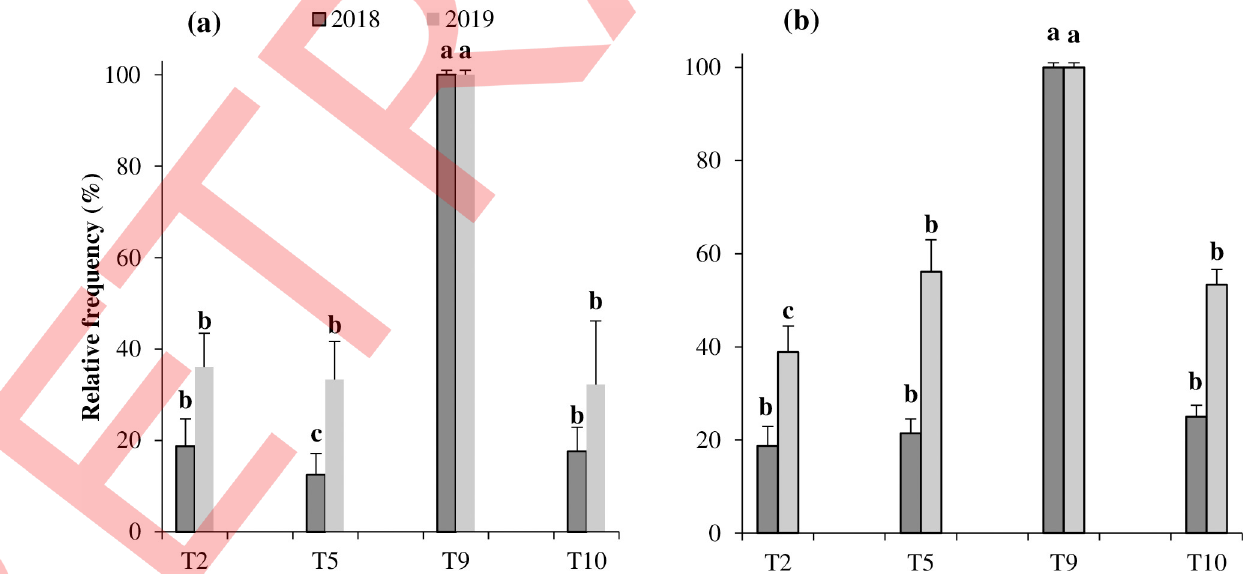
Fig 5. Relative frequency of horse purslane at 30 (a) and 45 (b) days after emergence in soybean field. T 2 : Horse purslane-free till 20 DAE, T 5 : All weeds-free till 20 DAE, T 9 : Weedy check horse purslane only, T 10 : Weedy-check all weeds.